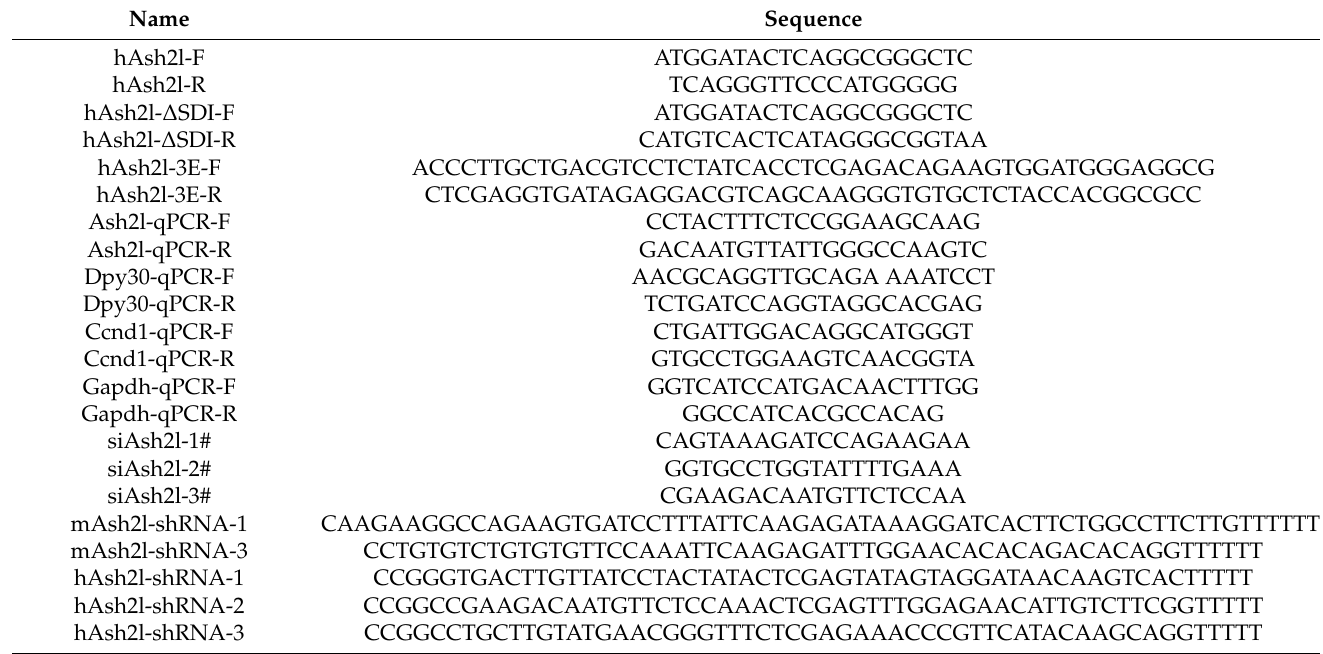
for 2 h at room temperature. Table 1. Primer sequences used in this article (“h” denotes human sequence, “m” denotes mouse sequence.).